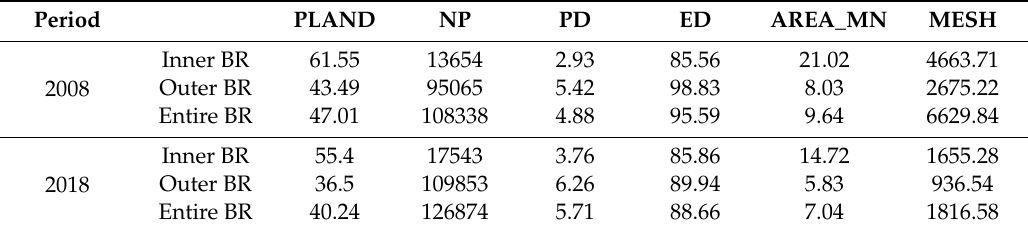
Table 3. Landscape metrics of grassland in the Bluegrass Region during 2008–2018.